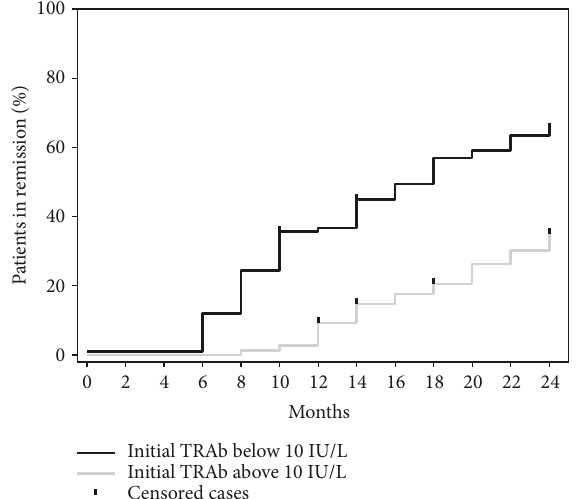
Figure 3: Kaplan-Meyer curve of relapse of Graves’ hyperthy- roidism in patients randomized to either fixed low dose block- replace treatment (grey) or just observation